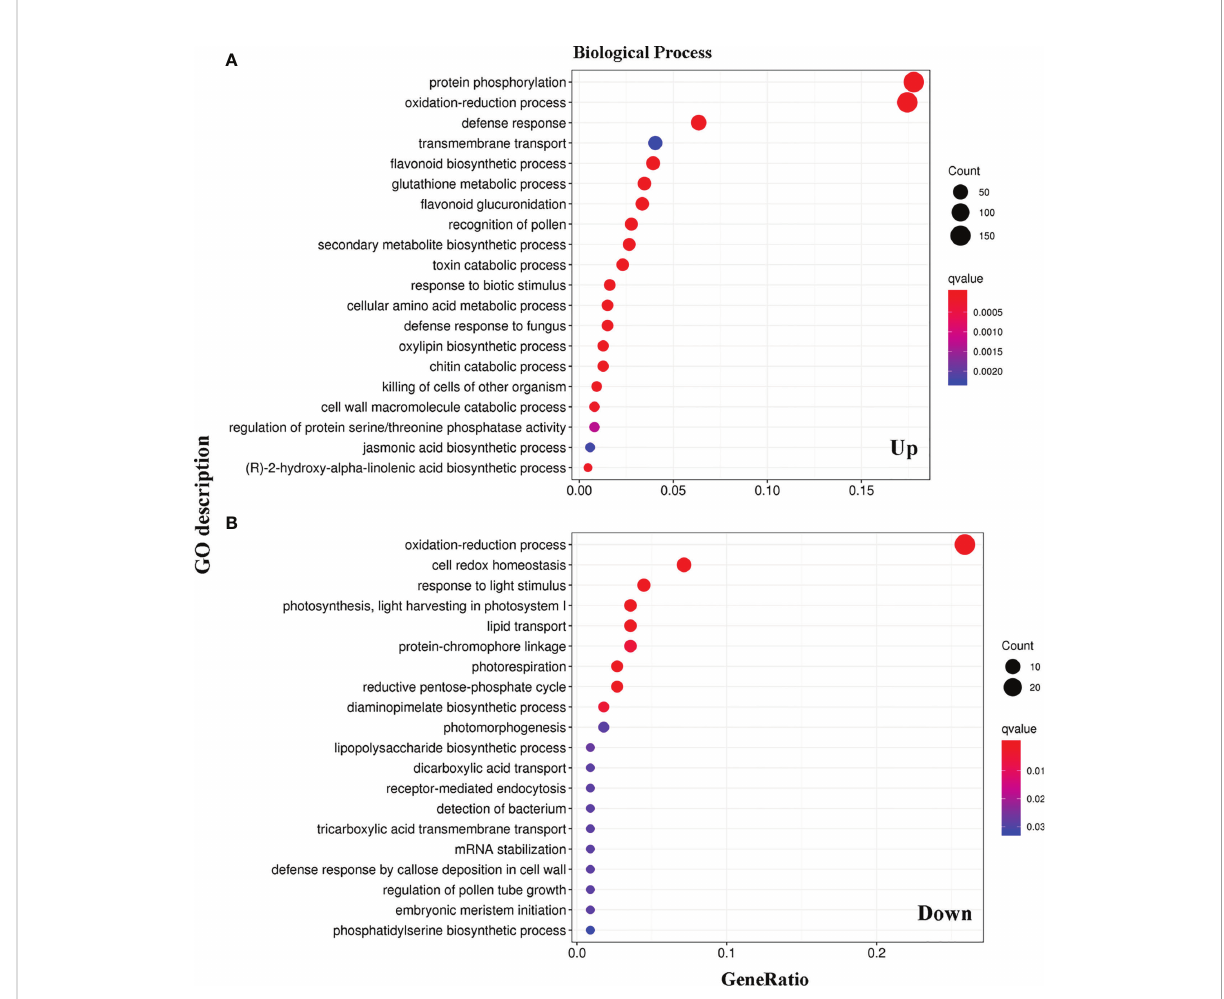
FIGURE 3 Categories and distribution of Gene Ontology (GO) terms in WT and LMM 5386 lines. (A) upregulated differentially expressed genes (DEGs); (B) downregulated differentially expressed genes